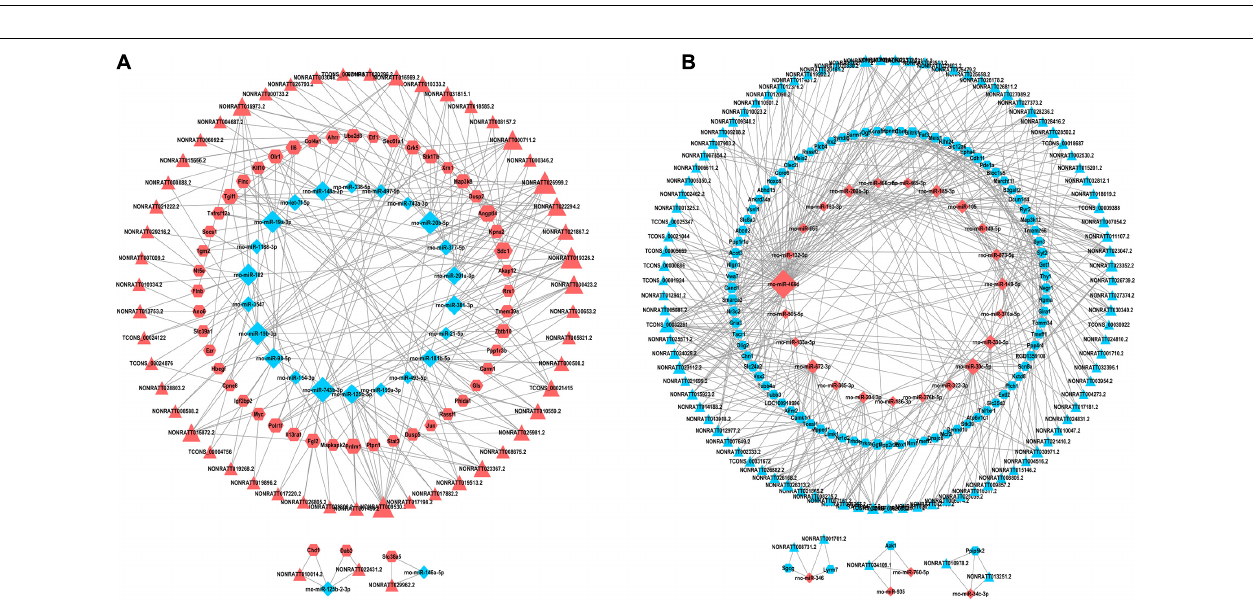
FIGURE 4 | lncRNAs-miRNAs-mRNAs regulatory network. Every node symbolizes one gene, and each edge indicates the interaction between genes. The shape of triangle represents lncRNAs, diamond represents miRNAs, and regular hexagon represents mRNAs. The blue color genes symbolize downregulated lncRNAs, mRNAs and miRNAs, while the red color indicates upregulated genes. (A) The upregulated lncRNAs and related network. (B) The downregulated lncRNAs and related network.